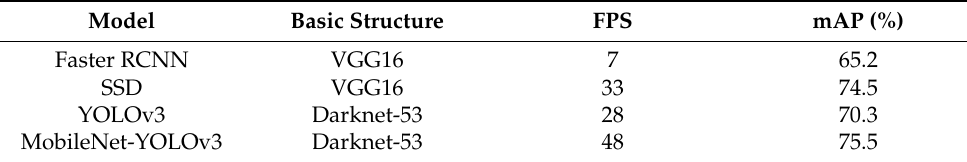
Table 2. Sign language recognition test results for different models.